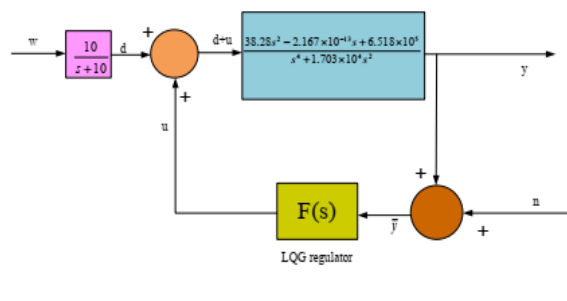
Figure 3 . LQG regulator Figure 3. the value of ‘d’ is a color noise signal with a spectral density of less than 10 rad/s, the value of ‘n’ is a white noise signal ()